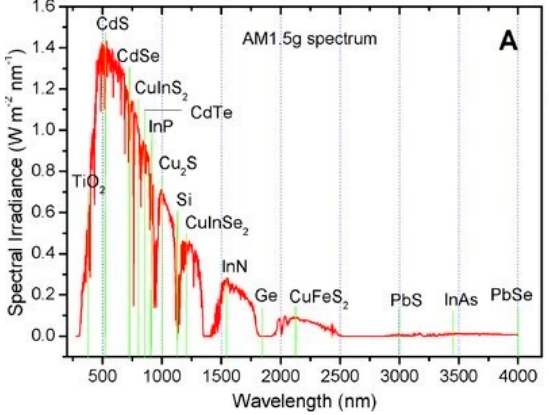
Figure 1. AM 1.5 G solar spectrum from ASTM G173 ‐ 03 reference spectra. The bandgaps for some common bulk semiconductors are: TiO 2 3.3 eV; CdS 2.45 eV; CdSe 1.7 eV; CuInS 2 1.54 eV; CdTe 1.5 eV; InP 1.34 eV; Cu 2 S 1.21 eV; Si 1.12 eV; CuInSe 2 1.0 eV; InN 0.8 eV; Ge 0.66 eV; CuFeS 2 0.6 eV; PbS 0.41